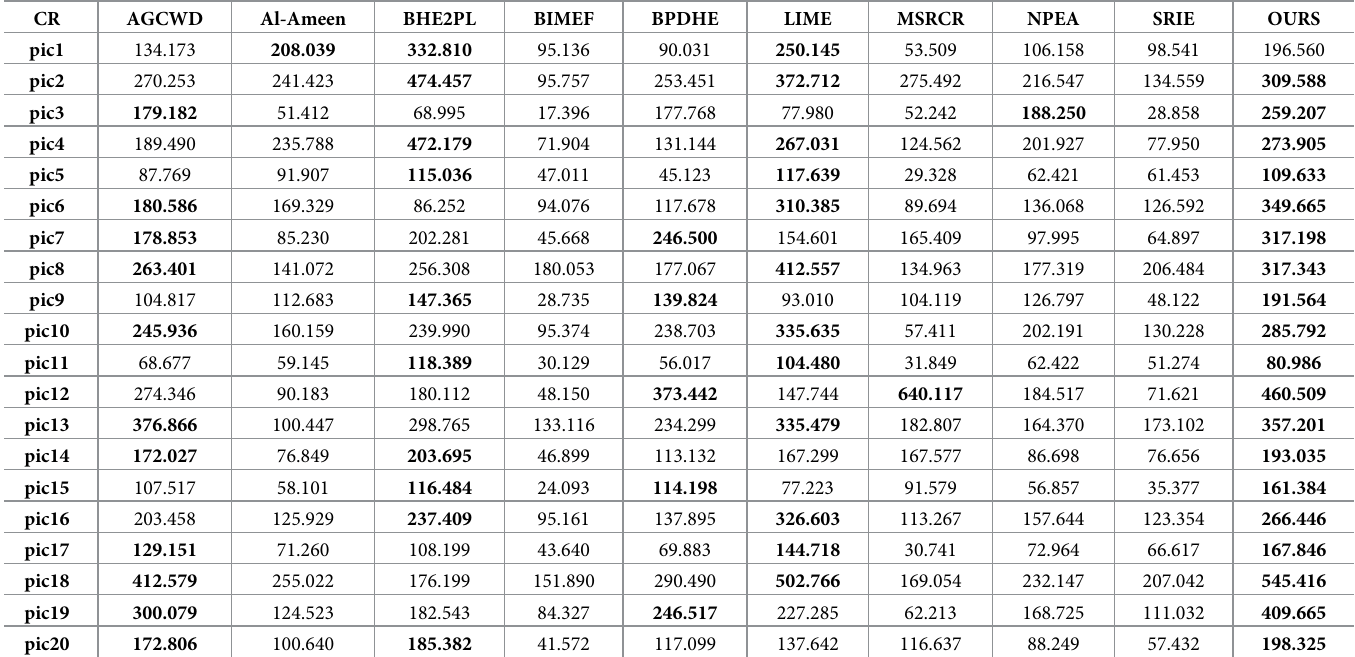
Table 11. Image contrast ratio values of 20 random images of MIT-5K.